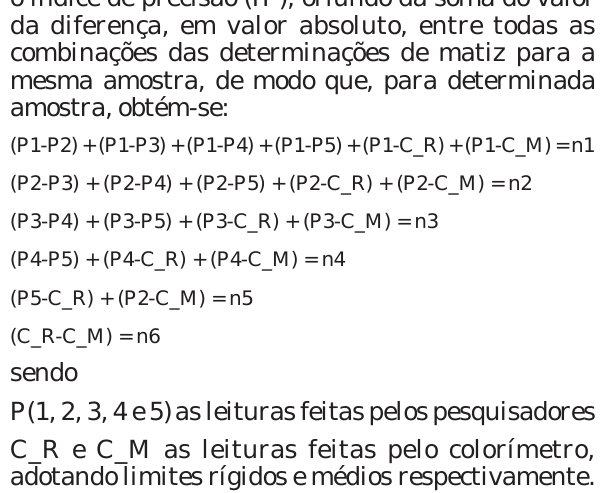
Quadro 1. Intervalos estabelecidos para transformar os valores da cor medidos com o colorímetro adotando limites rígidos e limites médios